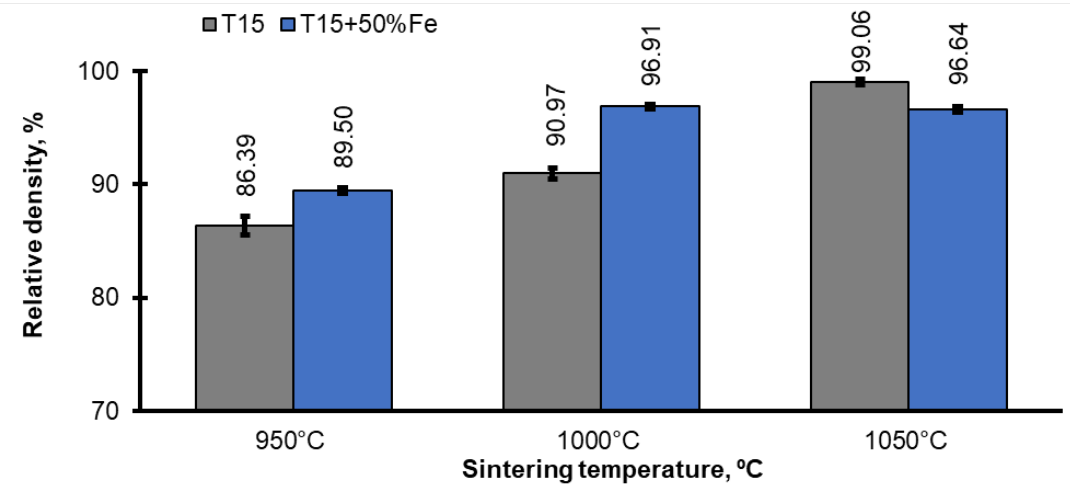
Figure 4. Relative densities of spark plasma sintered T15+50%Fe materials.